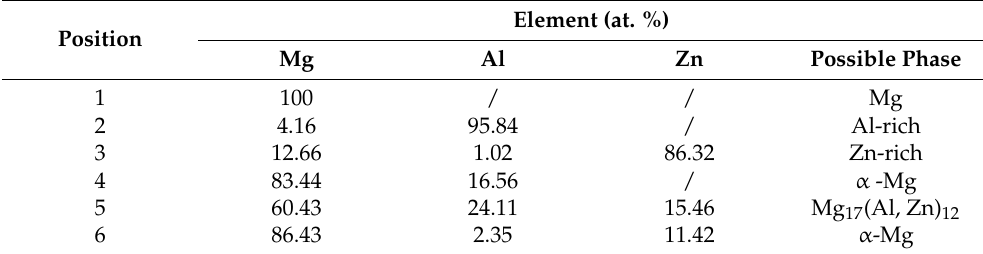
Table 2. EDS analysis results of positions marked in Figure 7.